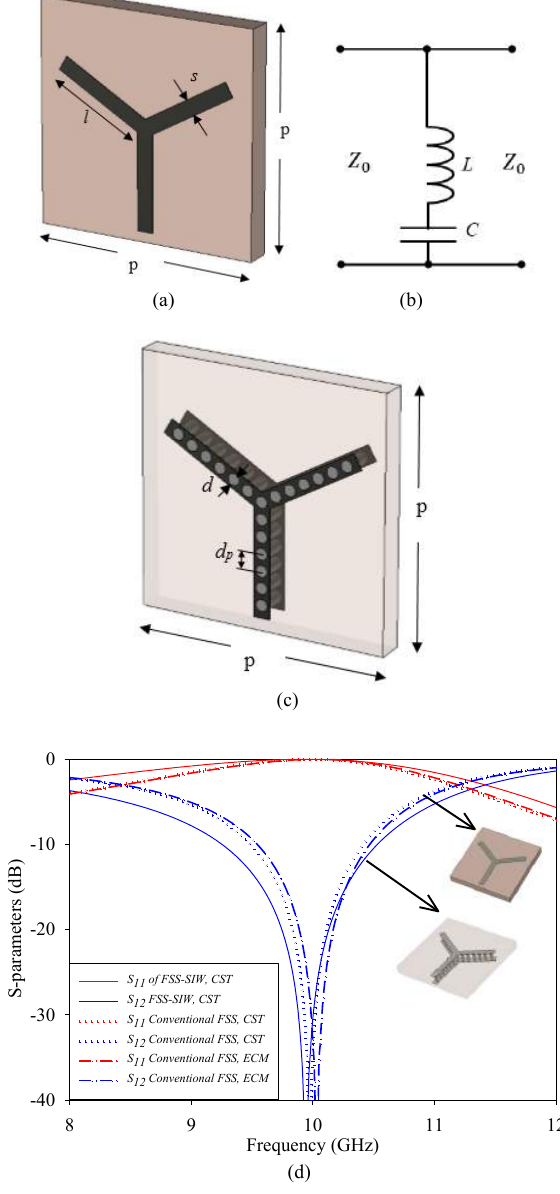
Figure 14. Tripole FSS unit cell. (a) Conventional form, and its (b) equivalent circuit model, (b) Proposed form. (c) Comparison of frequency